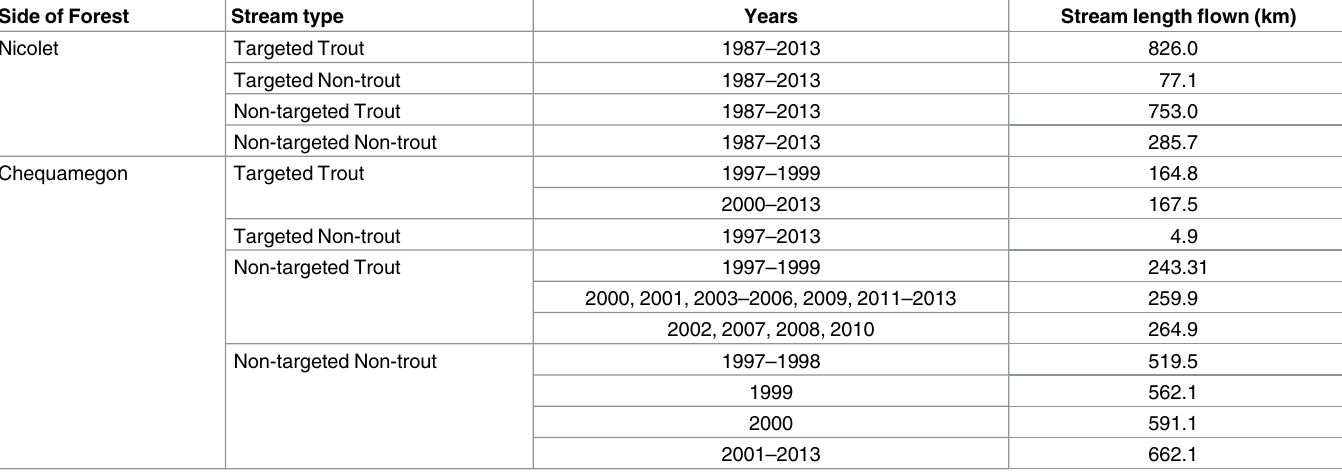
Table 1. Effort for aerial surveysof beaver colonies made October–November along four categories of streamsin the Chequamegon-Nicolet National Forest, 1987–2013 (Nicolet side) and 1997–2013 (Chequamegon side). Targeted streams were subject to the beaver control program. Side of